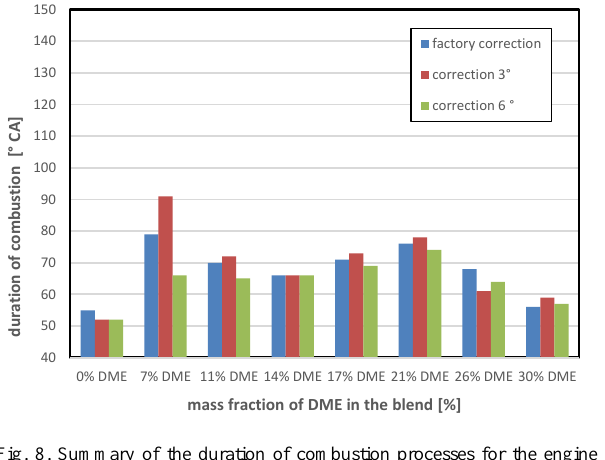
Fig. 8. Summary of the duration of combustion processes for the engine speed of 3000 rpm, fueled with LPG-DME mixtures, with the correction of the ignition angle. Engine load